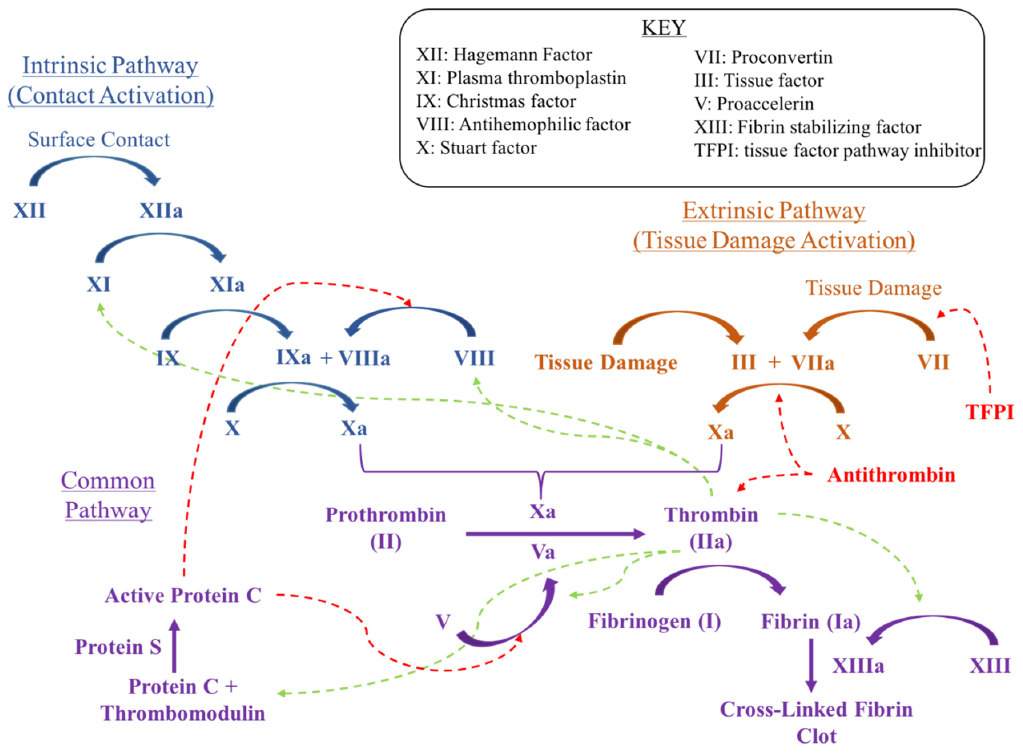
Figure 1. Overview of the coagulation pathway.